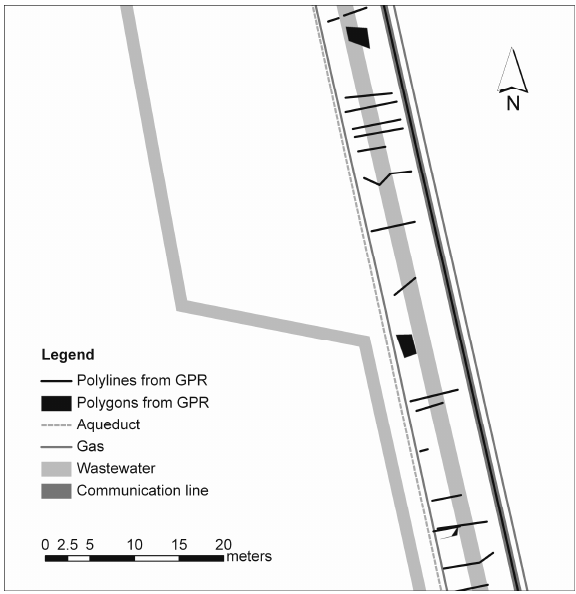
Figure 2. Portion of the 3D shapefiles of “inference from GPR” (black elements) superimposed to previously known underground